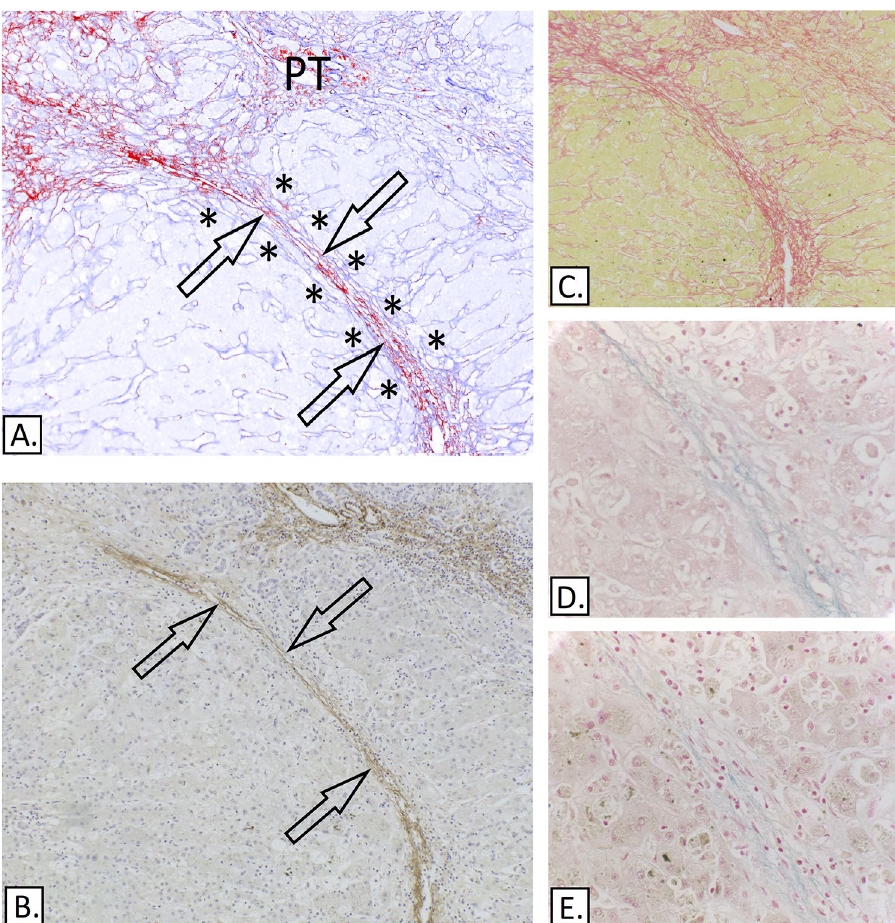
Figure 7. Submassive hepatic necrosis. ( A ) IHC-collagen I (ab6308) in red & collagen III (ab7778), spectrally unmixed channels from Nuance camera + software. It shows an area of parenchyma collapse (arrows) between two nodular areas (asterisks). ( B ) IHC-Elastin (ab9519). ( C ) Picro-Sirius red. ( D ) Victoria Blue. ( E ) Modified Victoria blue—no oxidation step. The collapsed area contains collagen I (A) and delicate elastin fibres (B), including oxytalan, as demonstrated by the differential staining between the standard Victoria blue (D) and the modified Victoria blue method